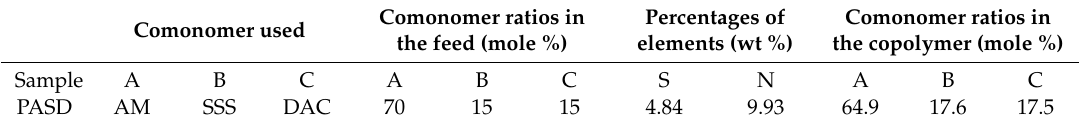
Table 1. Elemental analysis and composition of PASD.